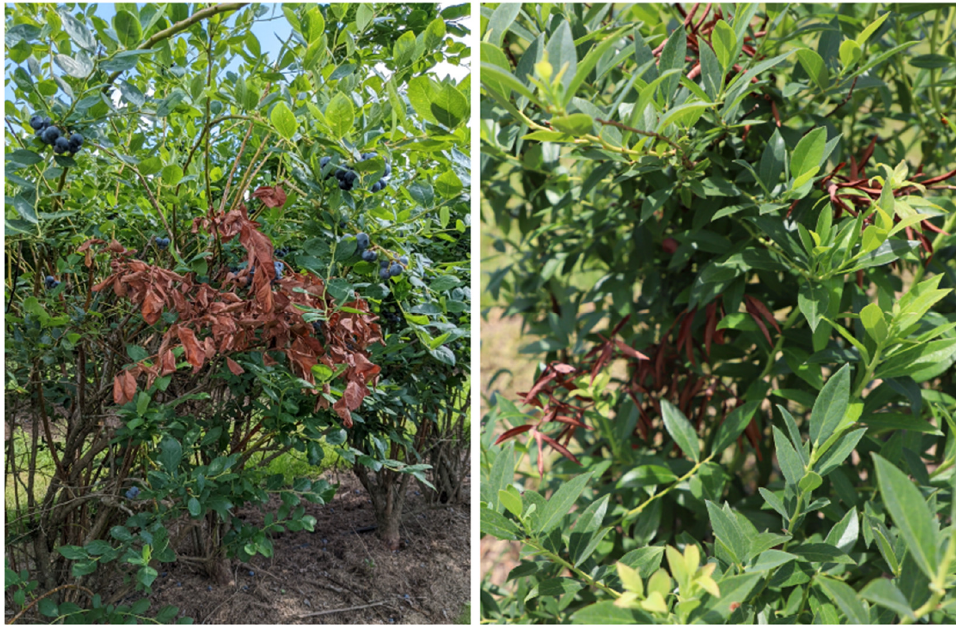
Figure 1. Symptoms of Botryosphaeria stem blight, pictures taken from blueberry farms in Alabama, USA in 2022.